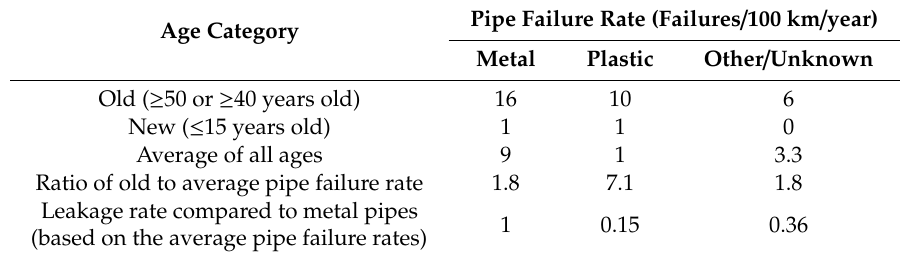
Table 1. The estimated pipe failure rates (failures / 100 km / year) for di ff erent material groups for ‘old’ and ‘new’ pipes, the ratio between the average failure rate and the failure rate of ‘old’ pipes, and the leakage rate of di ff erent material groups compared to the metal